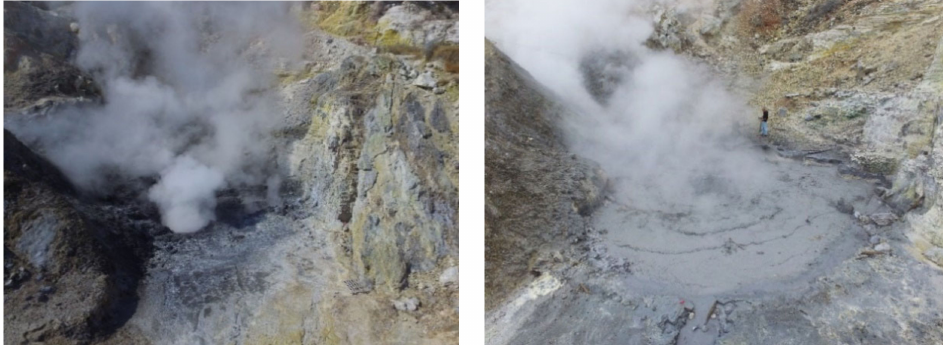
Figure 14. A dry bubbling mud pool ( left ) in September 2020 compared with a saturated bubbling mud pool ( right ) at the beginning of October